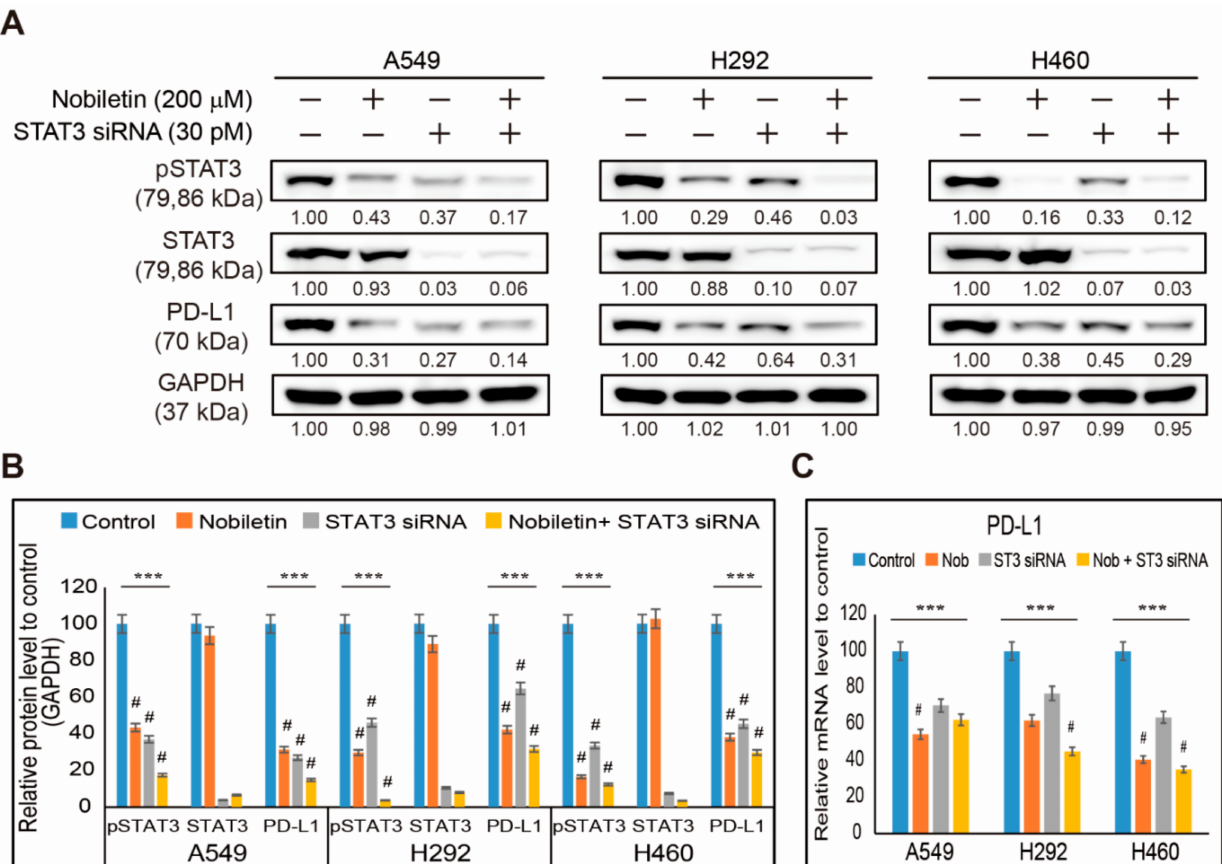
Figure 3. Nobiletin inhibits PD-L1 expression levels through STAT3. ( A ) Western blotting of A549, H292, and H460 cells was treated with STAT3 siRNA (30 pM) for 24 h, then treated with 200 µ M nobiletin for 48 h. Diagrams show the expression patterns of phosphorylated STAT3 and PD-L1 proteins. ( B ) Representative expression of proteins was quantified by densitometry and normalized to GAPDH protein. Controls proteins were set to 100%. All data repeated three times for confirmation. *** p < 0.001 (ANOVA test). # p < 0.001 vs. control. ( C ) Real-time qPCR of PD-L1 gene expression ( CD274 ) upon treatment with 30 pM STAT3 siRNA for 24 h followed by 200 µ M nobiletin for 48 h in A549, H292 and H460 cells. The representative expression of PD-L1 mRNA is shown; Cp values were then normalized to GAPDH mRNA. Controls are set to 100. *** p < 0.001. (ANOVA test), # p < 0.001 vs. control. ST3: STAT3; Nob: